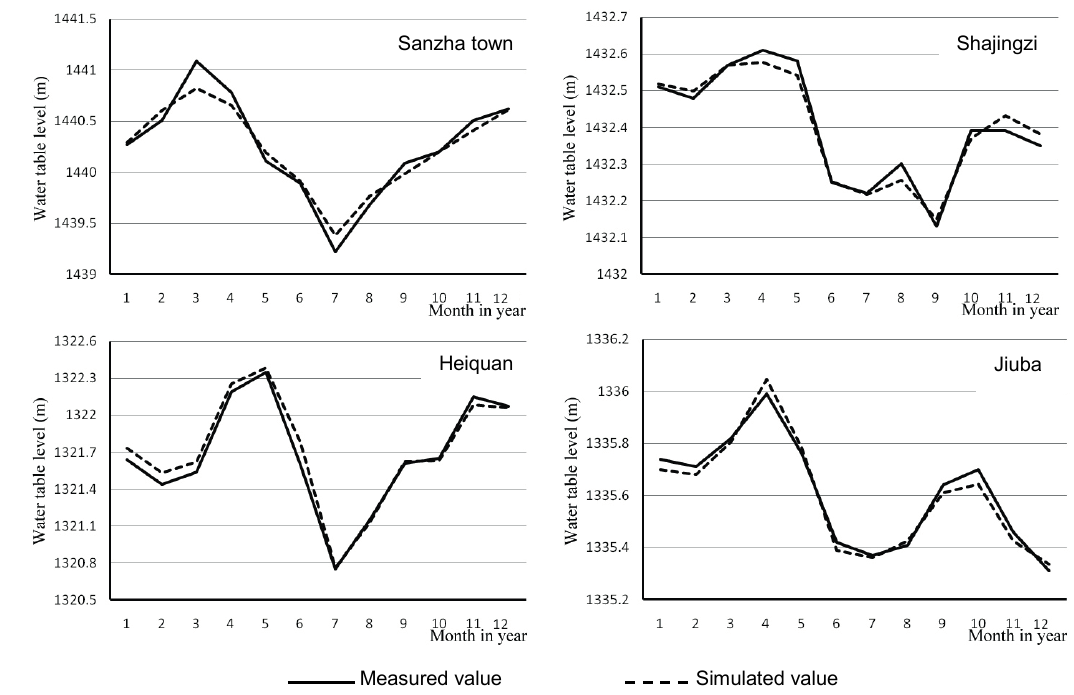
Fig. 3 Fitting curves of simulated and measured values of water